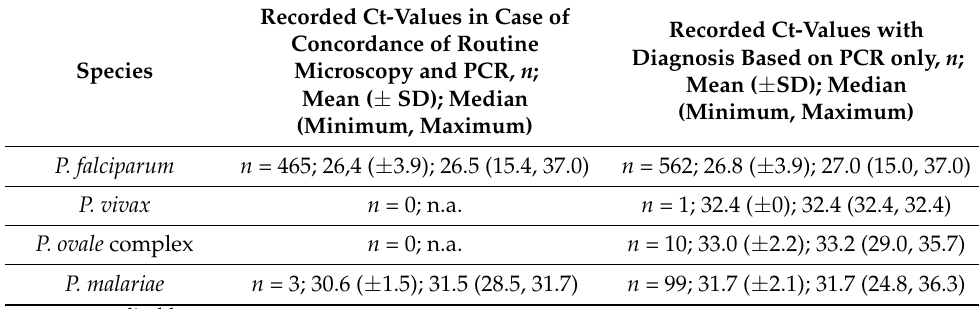
Table 7. Microscopically diagnosed parasitemia in parasites/ µ L as recorded for Plasmodium spp. detections in both routine microscopy and real-time PCR and in routine microscopy only. Recorded Parasitemia in Case of Recorded Parasitemia with Concordance of Routine Diagnosis Based on Routine Species Microscopy and PCR, n ; Microscopy only, n ; Mean ( ± SD); Mean ( ± SD); Median Median (Minimum, Maximum) (Minimum, Maximum) n = 463; 142,554.1 ( ± 213,046.9); n = 722; 109,950.5 ( ± 189,177.7); 63,800 (71, 1,859,200) 31,304 (70,